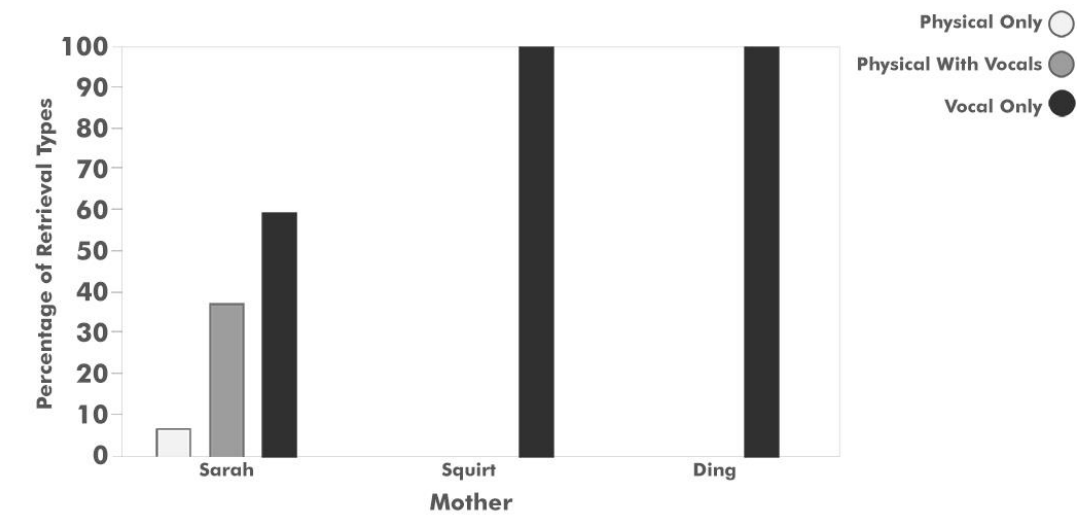
Figure 2. Relative percentage of retrieval types each mother used to recall her